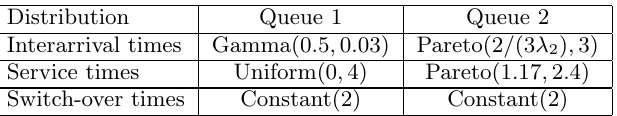
Table 3: Settings for Example 3.